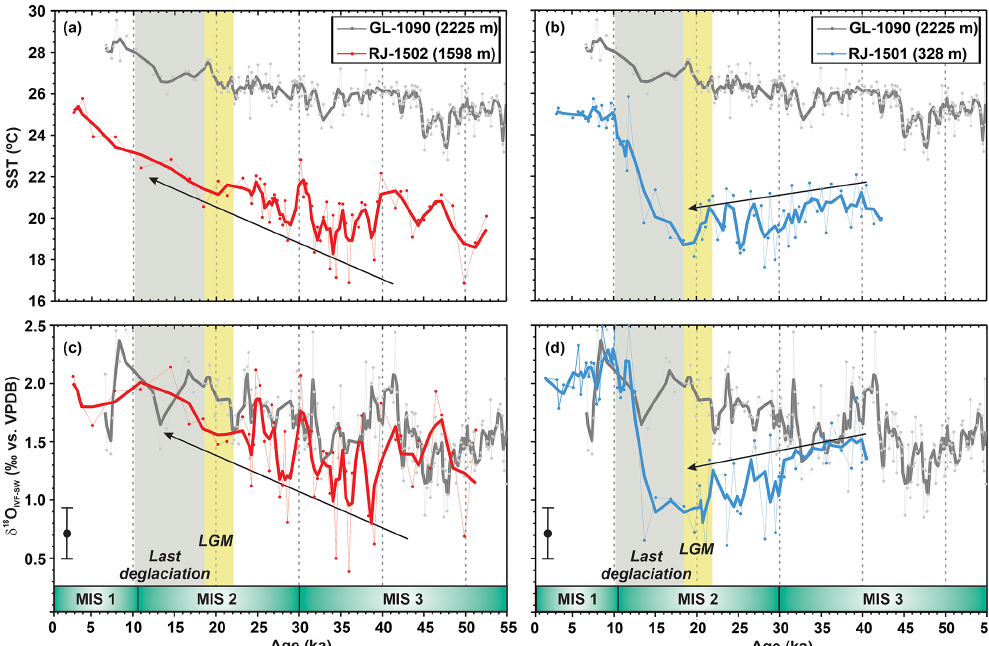
Figure 4. Comparison of the records from marine sediment cores RJ-1501 (blue), RJ-1502 (red) (this study), and GL-1090 (grey) (Santos (cid:48) )-derived sea surface temperature (SST) from cores RJ-1502 and RJ-1501 and Mg / Ca-derived SST from et al., 2017a). (a, b) Alkenone (U K 37 core GL-1090. (c, d) Ice-volume free seawater oxygen isotope ( δ 18 O IVF − SW ) from cores RJ-1502, RJ-1501, and GL-1090. Records are depicted by the original data (dots and thin line) and the respective three-point running average (thick line). Yellow and grey bars denote the Last Glacial Maximum (LGM) and last deglaciation, respectively. The vertical bars at the left of panels (c) and (d) indicate the total uncertainty associated with the δ 18 O IVF − SW . Marine isotope stages (MIS) are indicated at the bottom of the